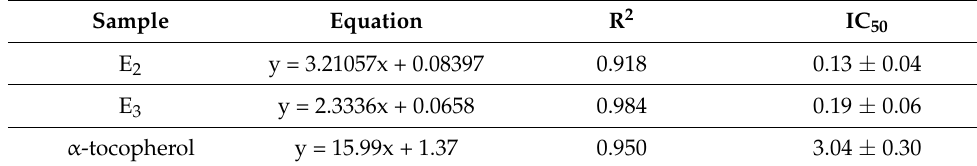
Table 7. IC 50 values (mg/mL) obtained using O 2.- radical-scavenging activity. Sample